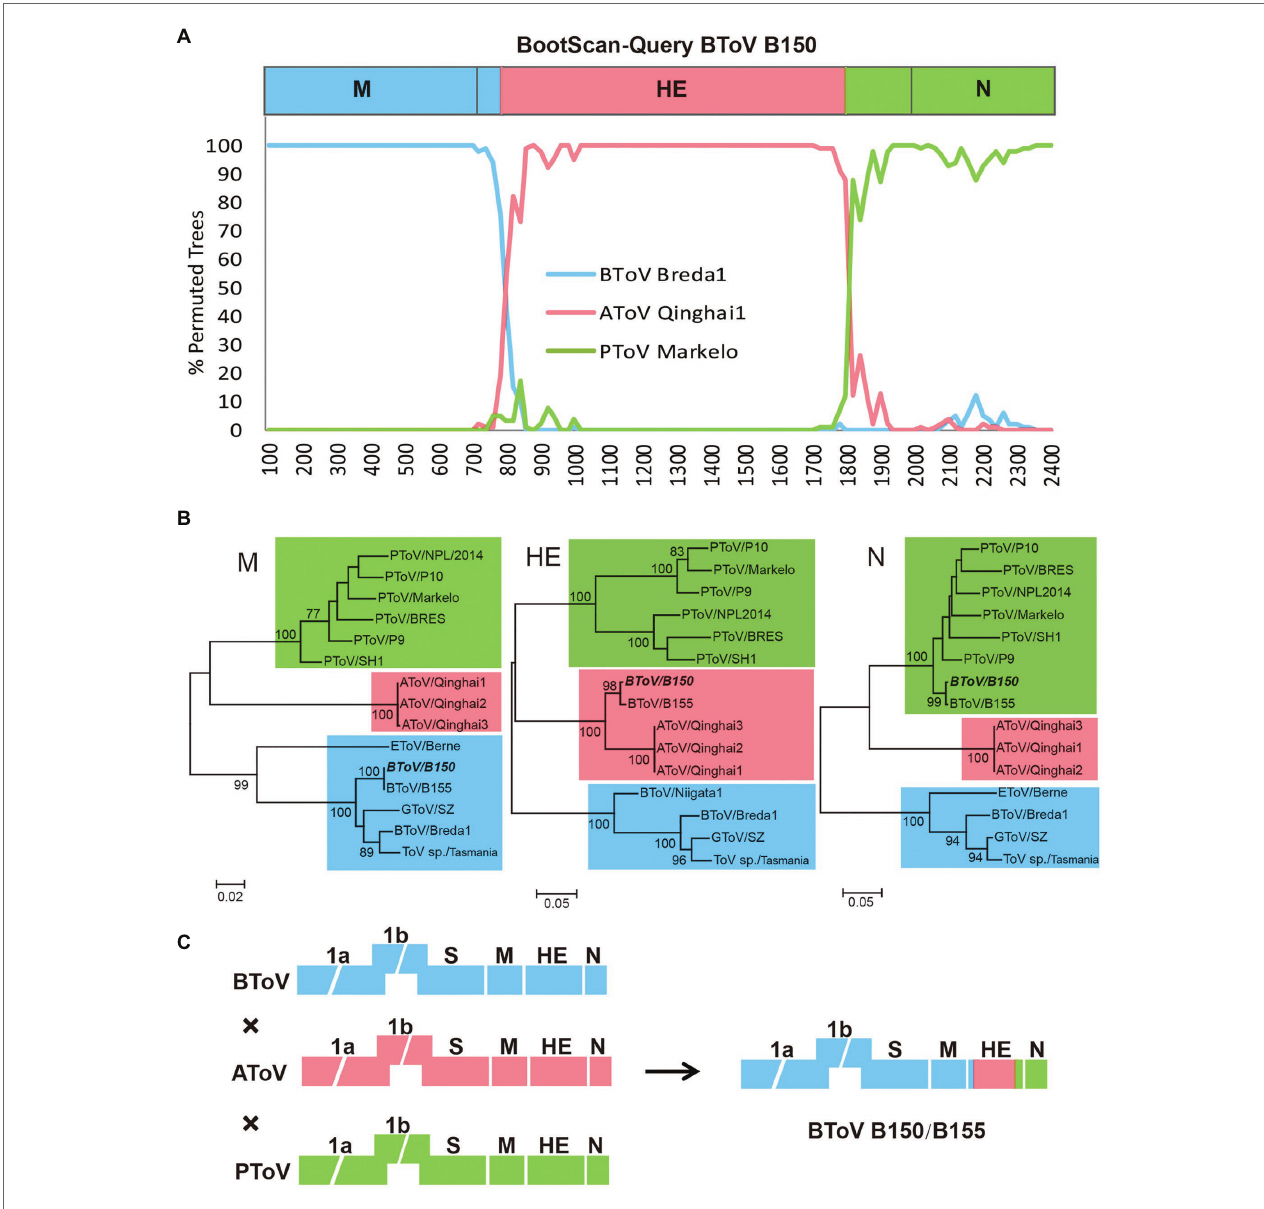
FIGURE 7 | Recombination analysis among BToV, AToV, and PToV. (A) Bootscanning analysis was conducted with BToV B150 as the query, BToV Breda1, AToV Qinghai1, and PToV Markelo as the parental sequences; (B) Phylogenetic trees were constructed based on complete nucleotide sequences of M, HE, and N genes, respectively, by the maximum likelihood method. BToV B150 is italic bold. ToV strains cluster with BToV Breda1, AToV Qinghai1, and PToV Markelo are in the blue, pink, and green backgrounds, respectively. Bootstrap values (>70%) are shown at the branches. Scale bars below indicate the nucleotide substitutions per site; (C) Presumptive recombination event of BToV B150. Torovirus genomes are depicted schematically with different colors (BToV, AToV, and PToV were represented by blue, pink, and green,